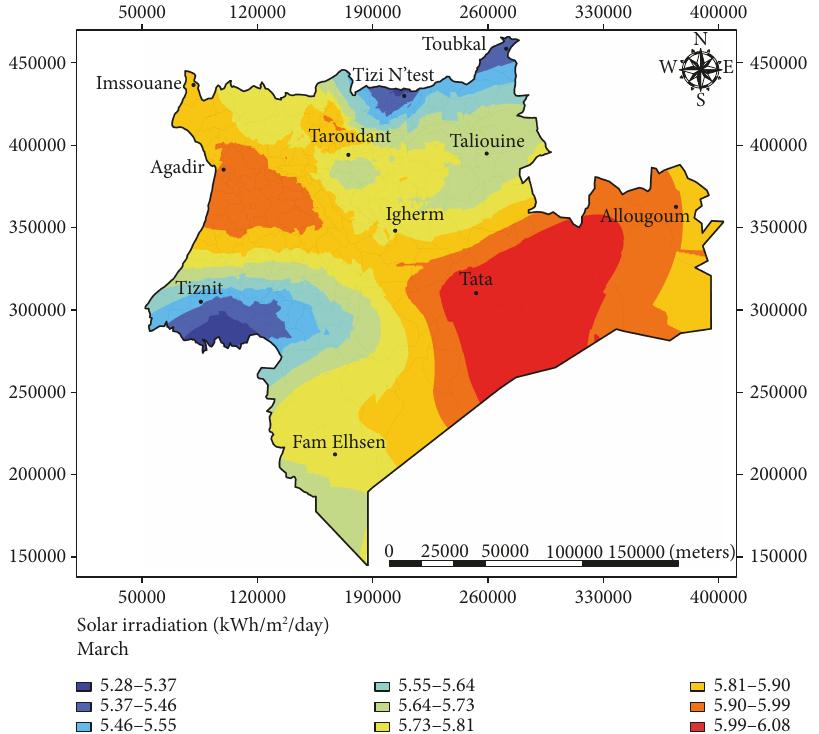
Figure 11: Solar energy potential map of the Souss-Massa area for the month of March as estimated by the ANN and designed with the Kriging interpolation technique.